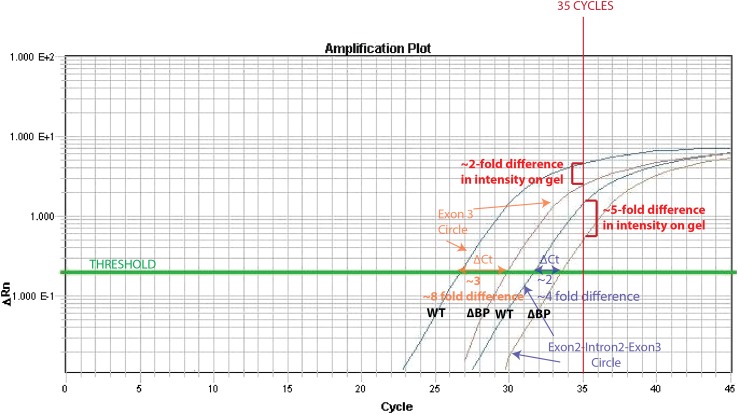
DOI:
http://dx.doi.org/10.7554/eLife.07540.026